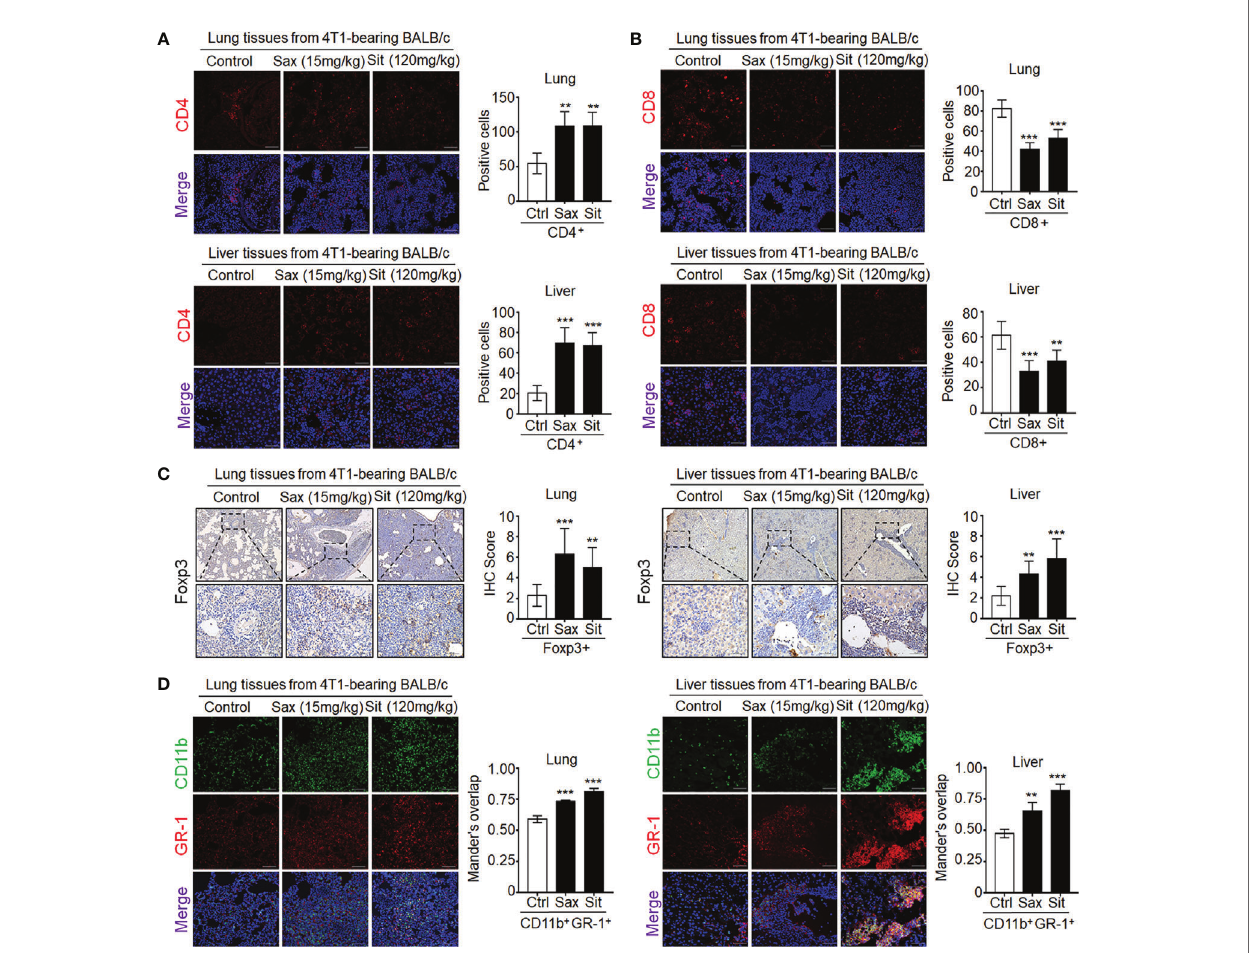
FIGURE 6 | DPP-4i promotes tumor-in fi ltrating immune-suppressive cells in metastasis sites of BALB/c mice. (A, B) DPP-4i enhances CD4+ T cells but decreases CD8+ T cells in lung and liver metastatic tissues. 4T1-bearing BALB/c mice were treated with Sax (15 mg/kg) or Sit (120 mg/kg) via oral gavage daily, and (A) CD4+ T cells and (B) CD8+ T cells were detected by indirect IF staining in lung and liver metastatic tissues. (C) DPP-4i promotes Foxp3+ cells in fi ltration in metastatic tissues. Foxp3+ cells were detected by IHC staining in lung and liver metastatic tissues. (D) DPP-4i promotes the in fi ltration of CD11b + Gr-1 + MDSCs in metastatic tissues. CD11b and Gr-1 expressions were detected by direct IF double staining in lung and liver metastatic tissues. Nuclei were counterstained with DAPI. Data are presented as mean ± SD of three independent experiments. Representative images are shown. Scale bar: 50 m m. **p< 0.01, and ***p < 0.001 between the indicated groups determined by unpaired Student ’ s t-test or the one-way analysis of variance